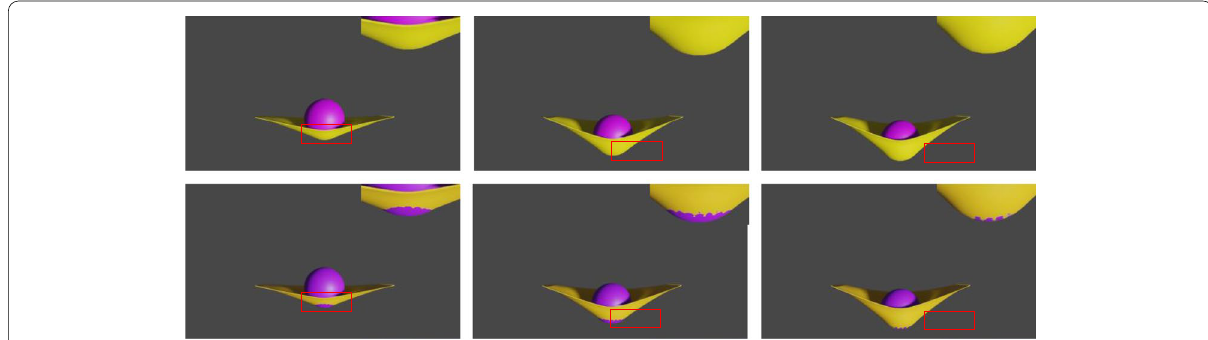
Fig. 9 Ablation study. The first row is the proposed method’s simulation result, and the second row is the ablation simulation